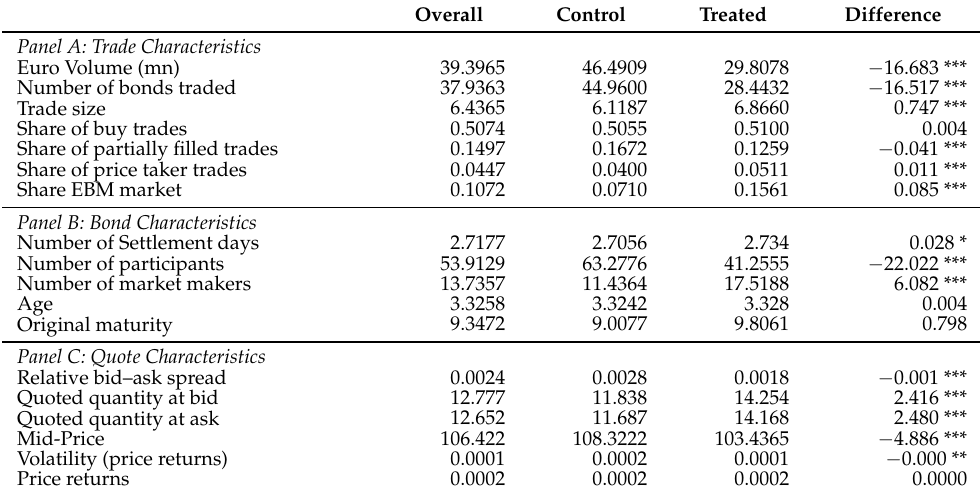
Table 4. Trade and quote